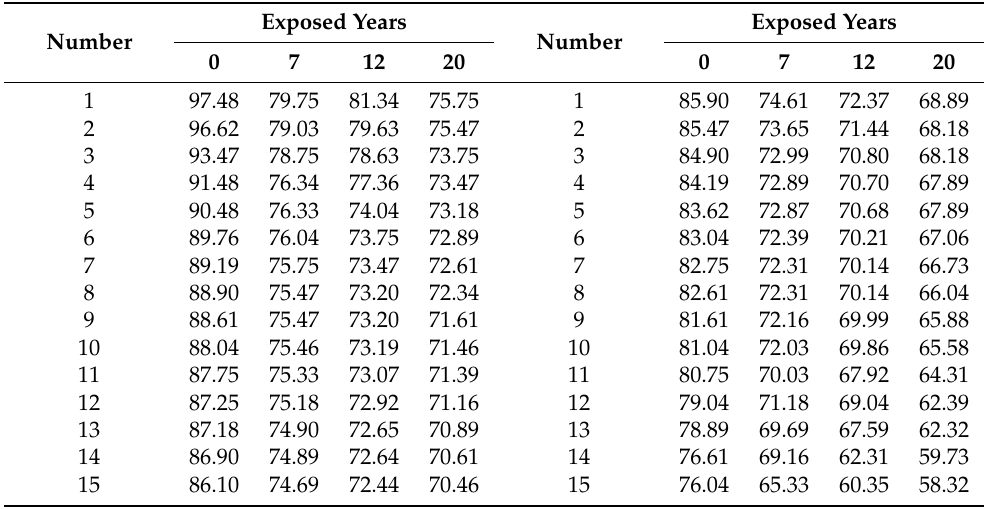
Table 3. Measurement of contact angles of epoxy primer-coated specimens with different dura- tions of exposure. (Unit: °).